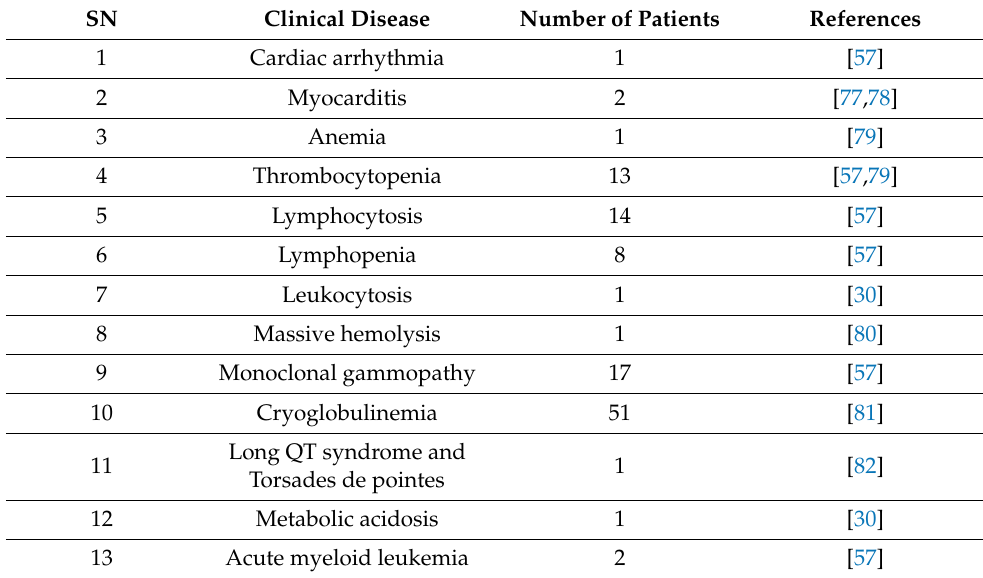
Table 2. Cardiovascular system disorders related to HEV infection.